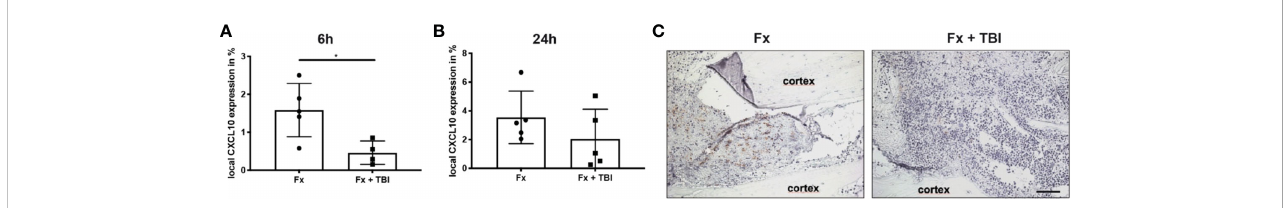
FIGURE 2 Local protein expression of CXCL10 in the hematoma. Longitudinal sections of the fracture bones were cut and stained for CXCL10. Staining was quanti fi ed by positive pixel amount relative to the total pixel. (A) Local CXCL10 protein expression at 6h and (B) 24h after fracture. (C) Representative images from the fracture area at 6h after fracture. Scale bar = 50 µm. * indicates p-value below 0.05 for comparison between Fx and